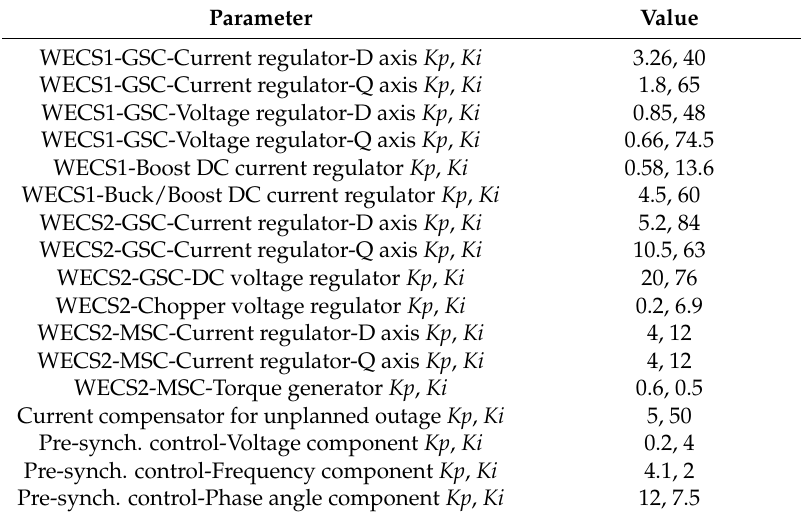
Table 3. Control